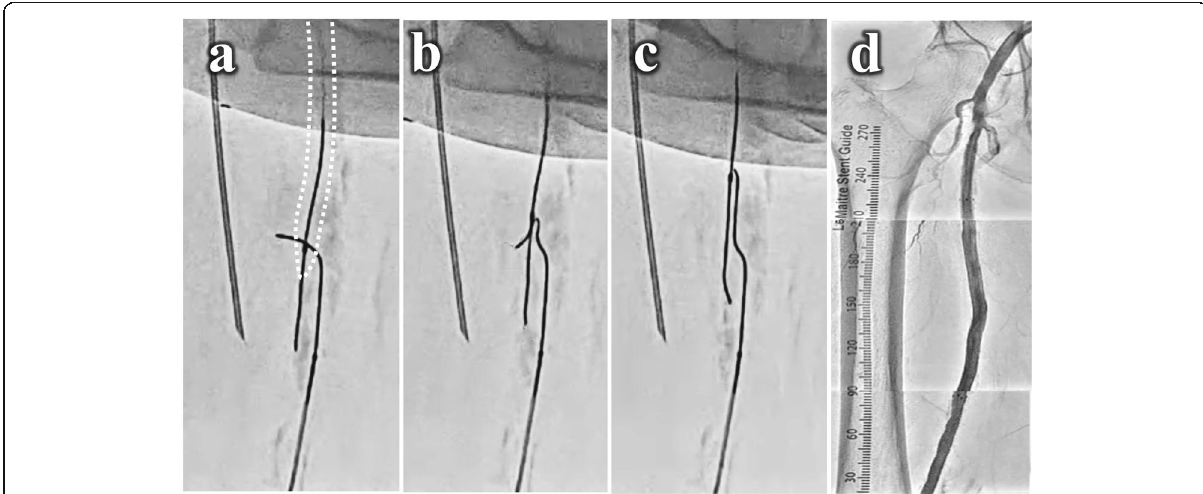
Fig. 3 The process of the “ balloon snare ” of the “ needle re-entry ” technique. A to C . Since the retrograde guidewire passed into the 5.0-mm balloon (white dotted line), when the balloon was withdrawn, and the guidewire was caught with the balloon and successfully advanced into the antegrade subintimal space. D . After the “ pave-and-crack ” technique was performed, a 6.0 × 250-mm stent graft combined with a 6.5 × 150- mm interwoven stent were implanted, final angiography showed a satisfactory result without